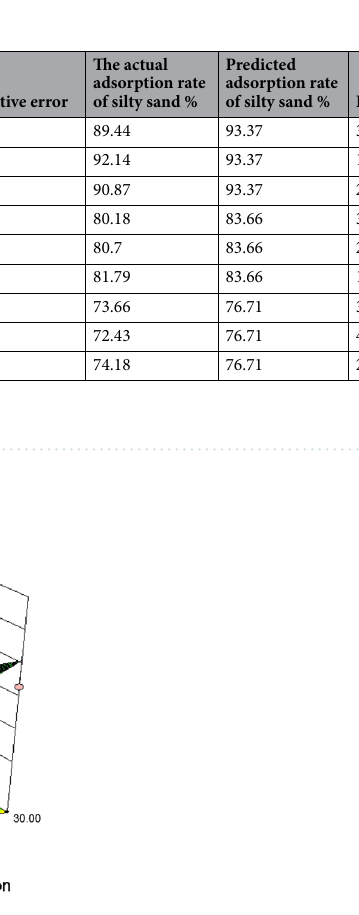
Figure 9. Effects of temperature and pH on the adsorption rate of silts.